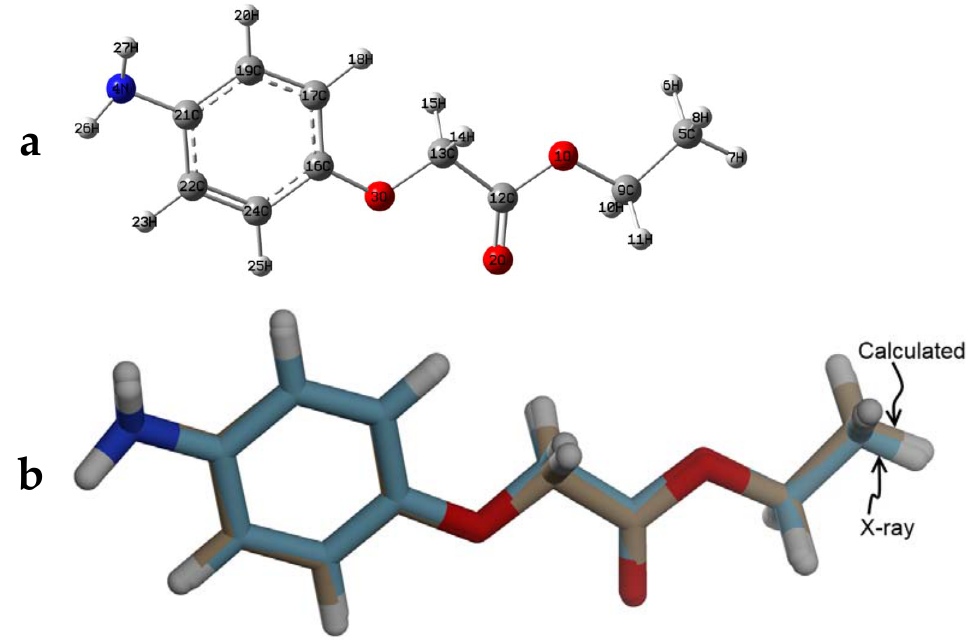
Figure 7. The optimized geometry ( a ) and overlay of the optimized with experimental structures, ( b ) for 4.